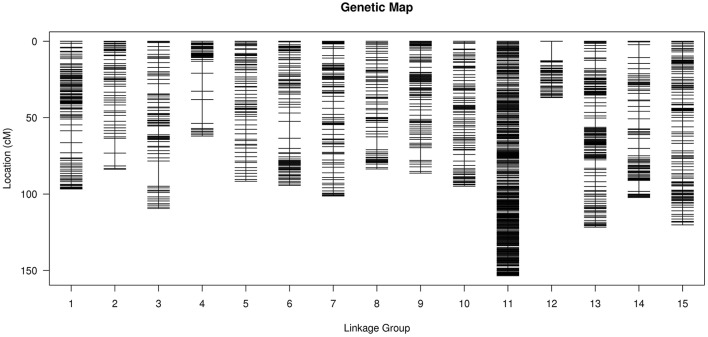
Distribution of SLAF markers on the 15 linkage groups of flax. A black bar indicates a SLAF marker. The x-axis represents the linkage group number and the y-axis indicates the genetic distance (cM) within each linkage group.